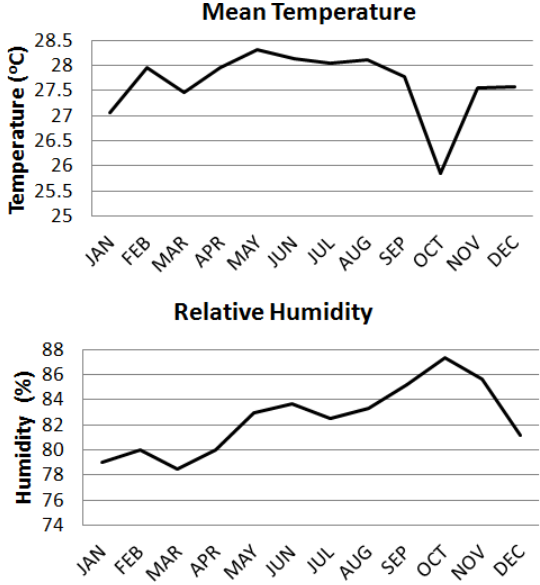
Fig. 6. Mean temperature and mean relative humidity of the Colom- bian Caribbean zone (Ortiz and Rosales,